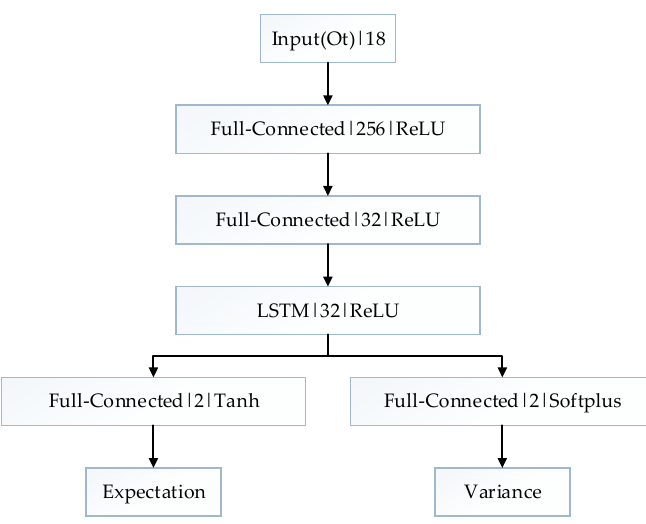
Figure 5. The network structure of IA3C.